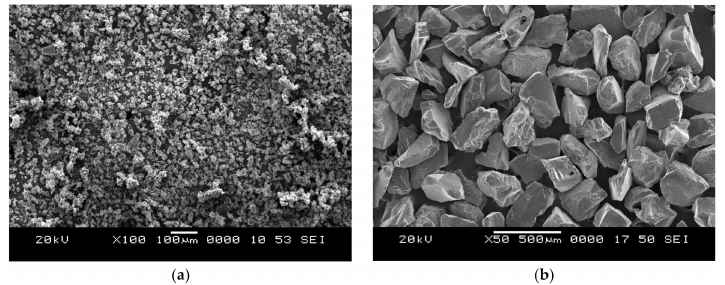
Figure 1. Scanning electron micrographs of ( a ) Crumb rubber and ( b ) Silicon carbide